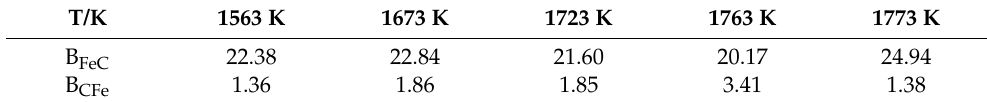
Table 6. Interaction parameters of B CFe and B FeC in liquid Mn-Fe-C ternary alloys.